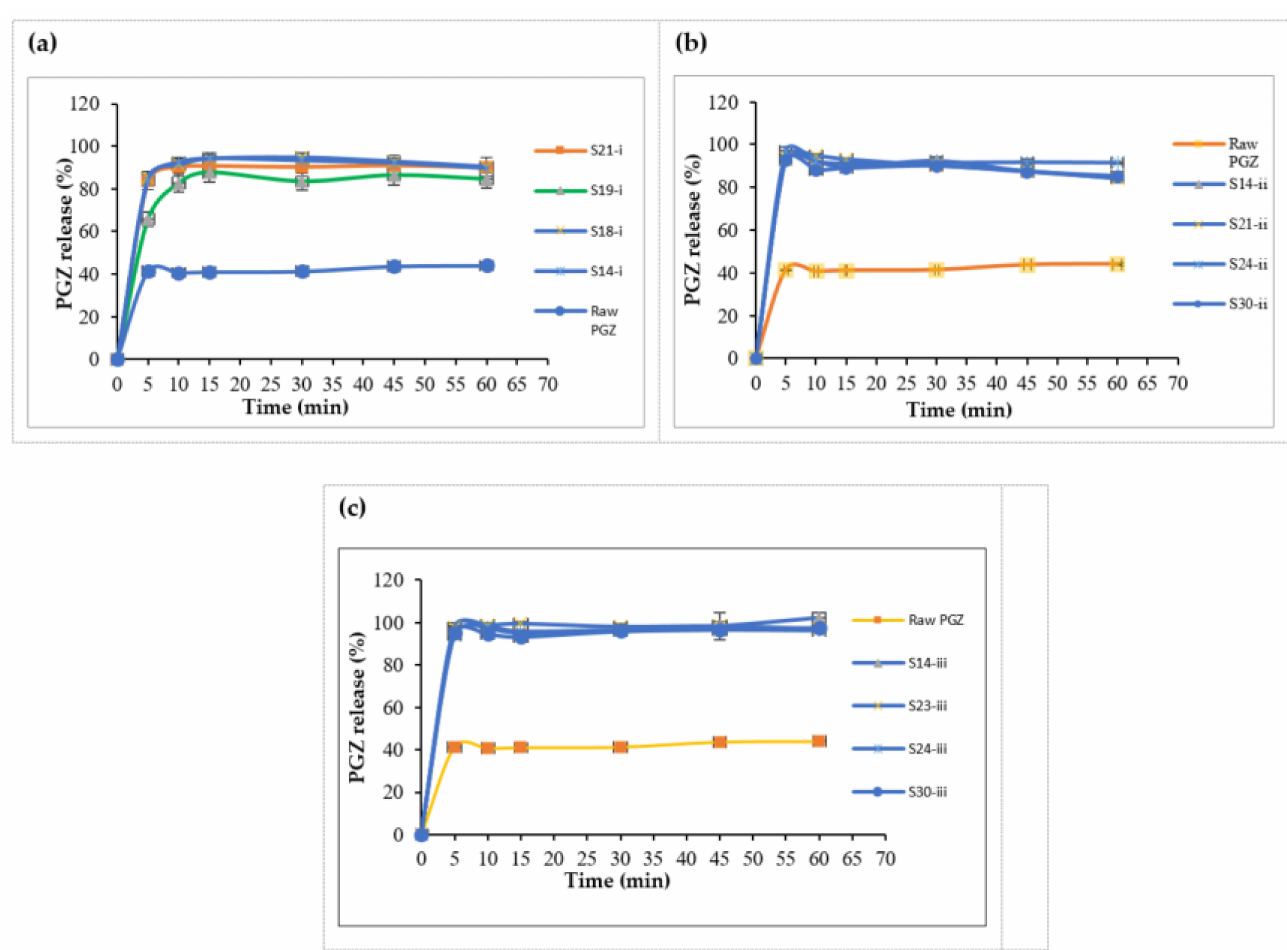
Figure 7. In vitro dissolution profile of PGZ from L-SNEDDS formulae: ( a ) System I, ( b ) System II and ( c ) System III. Abbreviations: L-SNEDDS, liquid self-nanoemulsifying drug delivery system; PGZ, Pioglitazone